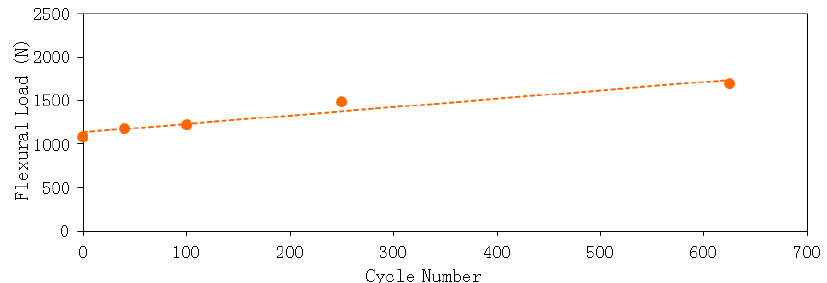
Figure 9. Maximum flexural loads vs. cycle numbers for the control specimens. Each cycle is equivalent to 2 h.